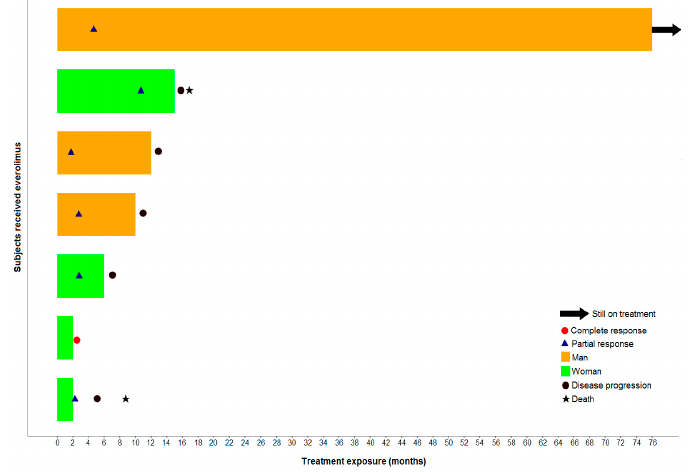
Figure 3. A swimmer plot indicating the time to response for the seven patients with objective responses, according to local tumor assessment. Each bar represents a different patient.